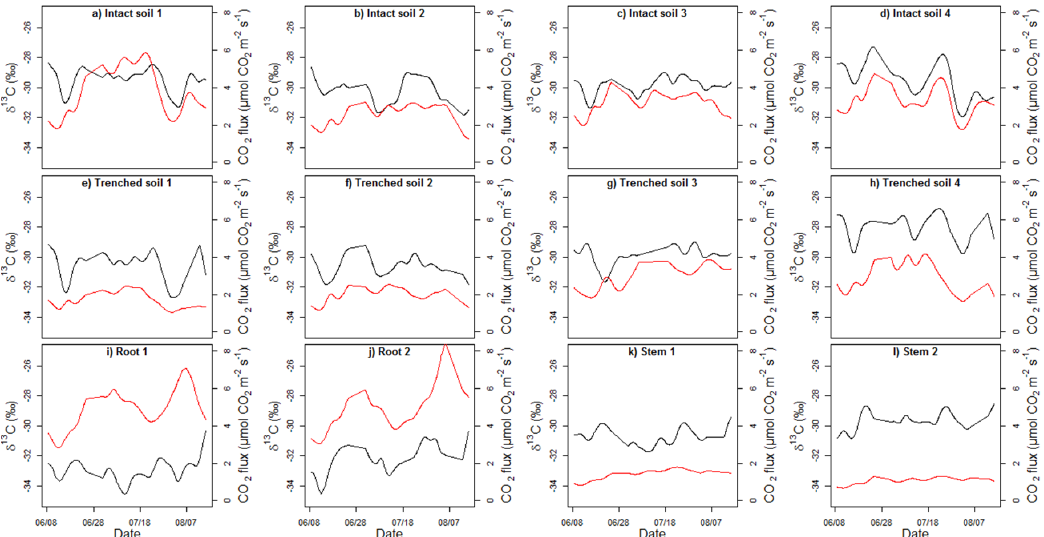
Figure 7. δ 13 C of the CO 2 fluxes determined by Keeling plots (black lines) and the CO 2 fluxes (red lines) for each of the plots throughout the measurement period. δ 13 C and CO 2 fluxes are each shown as rolling averages of the daily means. ( a ) to ( d ) Intact soil 1 to Intact soil 4. ( e ) to ( h ) Trenched soil 1 to Trenched soil 4. ( i ) and ( j ) Root 1 and Root 2, respectively. ( k ) and ( l ) Stem 1 and Stem 2, respectively.